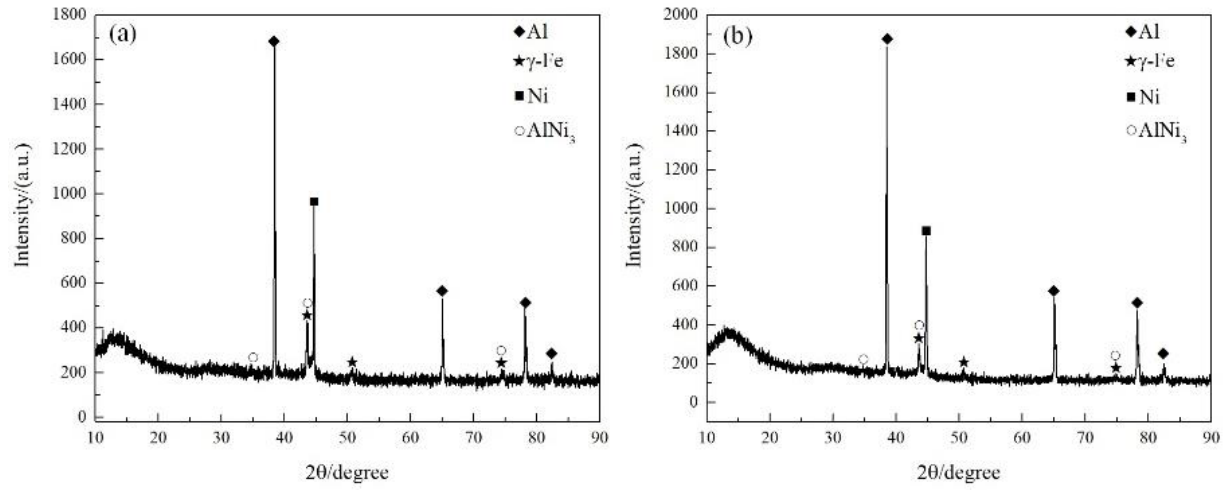
Figure 7. XRD analysis of the lap interface: ( a ) 800 rpm and ( b ) 1200 rpm.